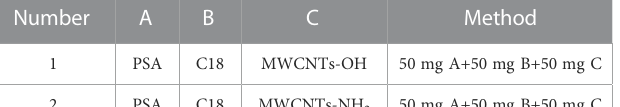
TABLE 1 Composition of the two pre-treatment methods.